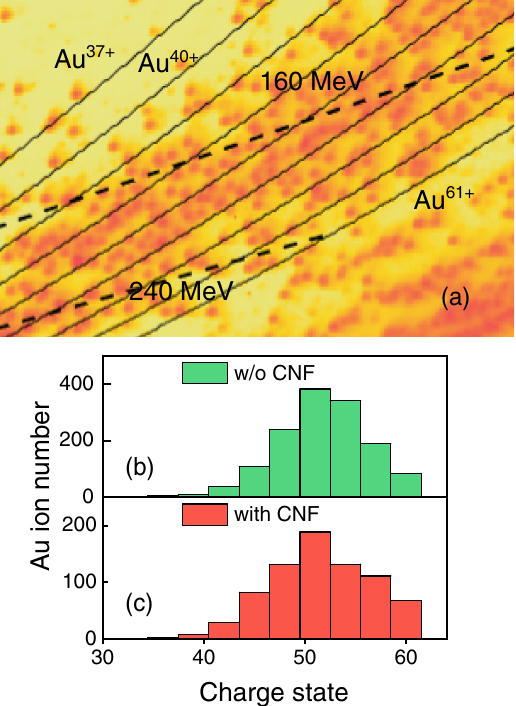
FIG. 5. (a) Schematic of the statistics of the charge-state distributions. The solid lines represent the constant charge states. Charge-state distributions of Au ions from (b) single-layer and (c) double-layer